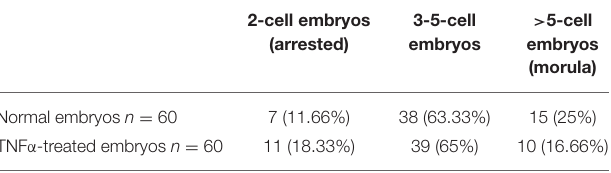
TABLE 2 | The developmental rate of embryos collected from mice at 1 dpc and cultured in vitro for 24h in the presence or absence of TNF α ( χ 2 test p ≥ 0.05).